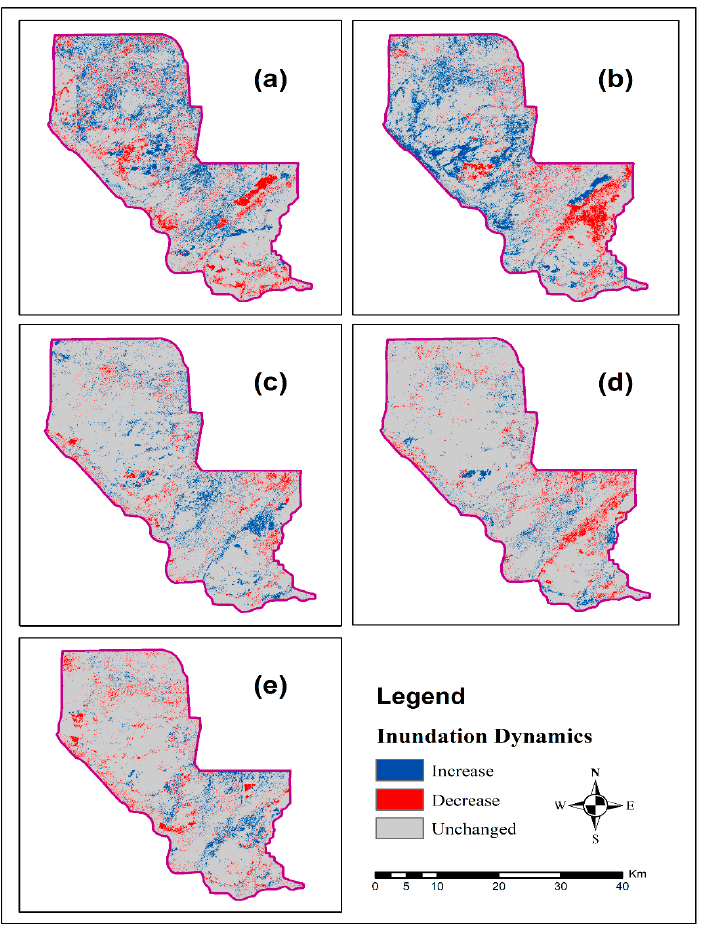
Figure 7. The spatial distribution of inundation dynamics in wet season: ( a ) 2002–2006, ( b ) 2006–2010, ( c ) 2010–2014, ( d ) 2014–2018, and ( e )